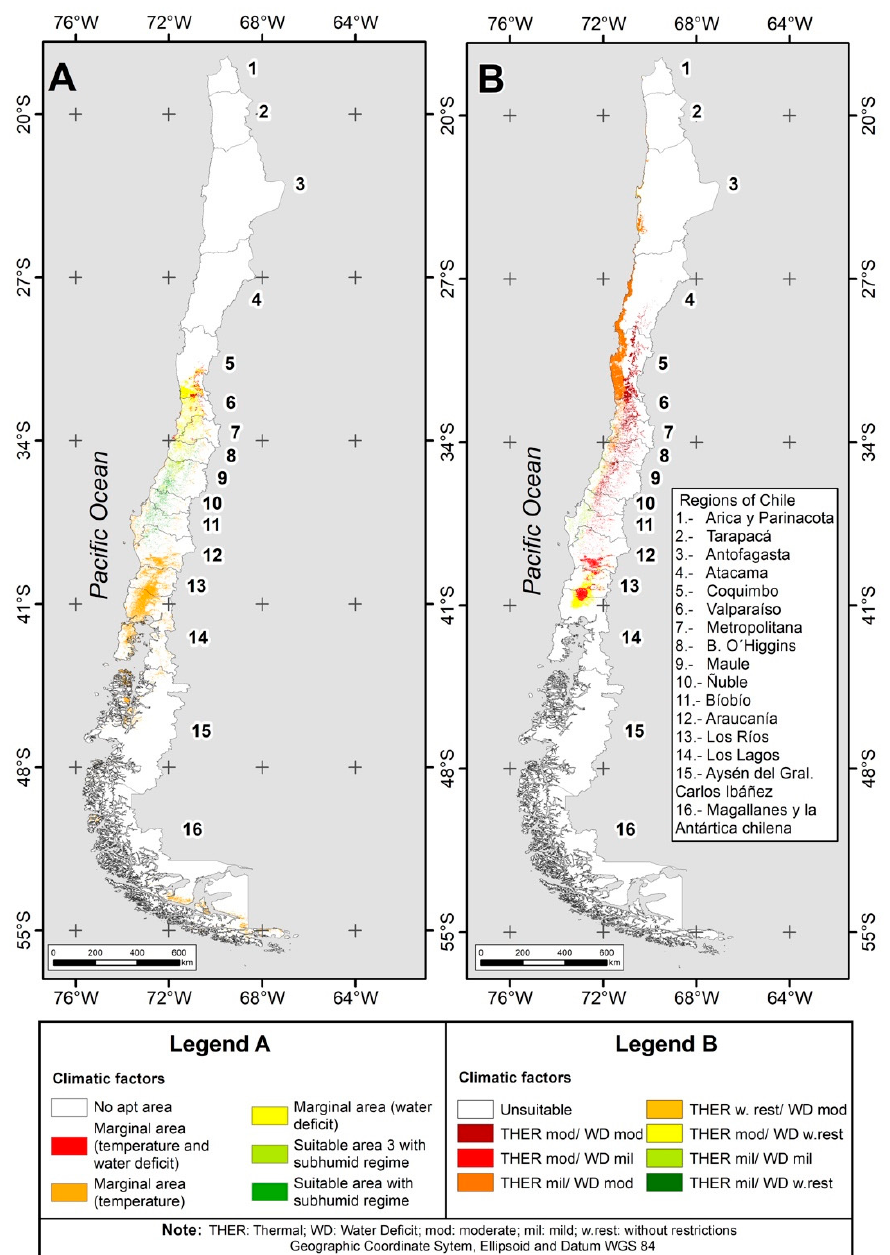
Figure 2. Suitability agro–climatic zoning for castor bean in Chile, according to the simplistic method ( A ) and presence-species method ( B ), considering current land uses as limitations for determination of land aptitude. Therm: Thermic; WD: Water deficit; mod: Moderate; mil: Mild; w. rest: Without restriction. Table 5. Regional surface area with agro–climatic aptitude for castor bean production as a national oil-seed crop (ha), both with the simplistic and the presence-species methodologies. Chilean total area: 75.29 million ha.